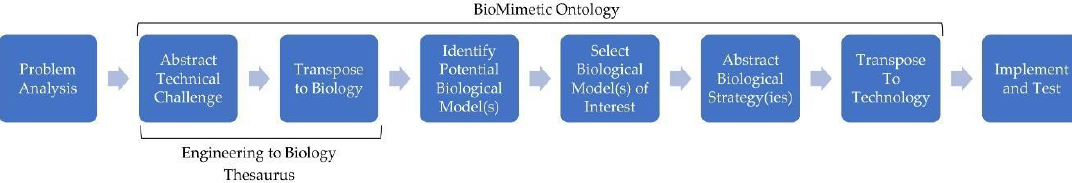
Figure 1. Illustration of the traditional problem-driven biomimicry design process and steps that selected tools facilitate. E2B Thesaurus (Step 2 and 3) and BioMimetic Ontology (Step 2 to 7) [12].